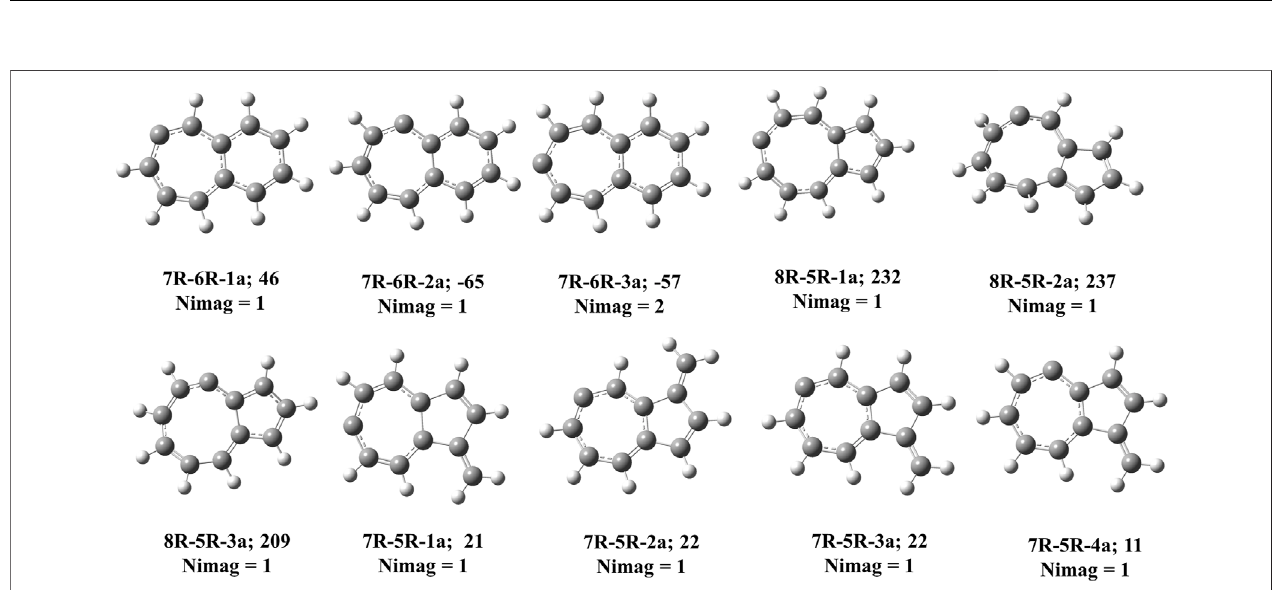
FIGURE8| CarbenecounterpartsofvariouscyclicalleneisomersatlocalmaximainC 11 H 8 potentialenergysurface.ZPVE-correctedrelativeenergies(inkJmol − 1 ), absolute dipole moment values (in Debye) are calculated at the B3LYP/6-311 + G (d,p) level of theory.